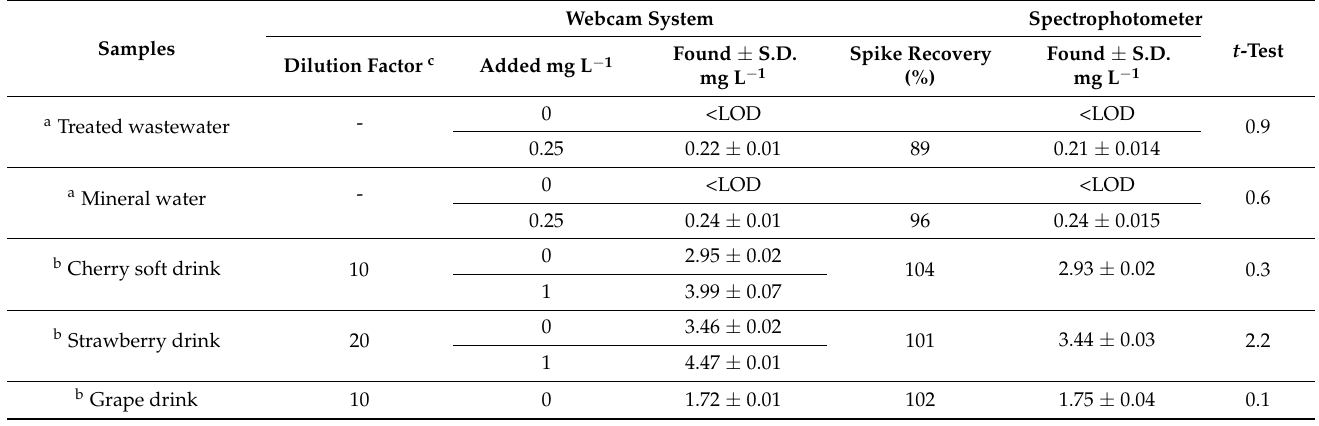
Table 2. Concentrations of norfloxacin and allura red obtained from colorimetric measurements in environmental and food samples (n =